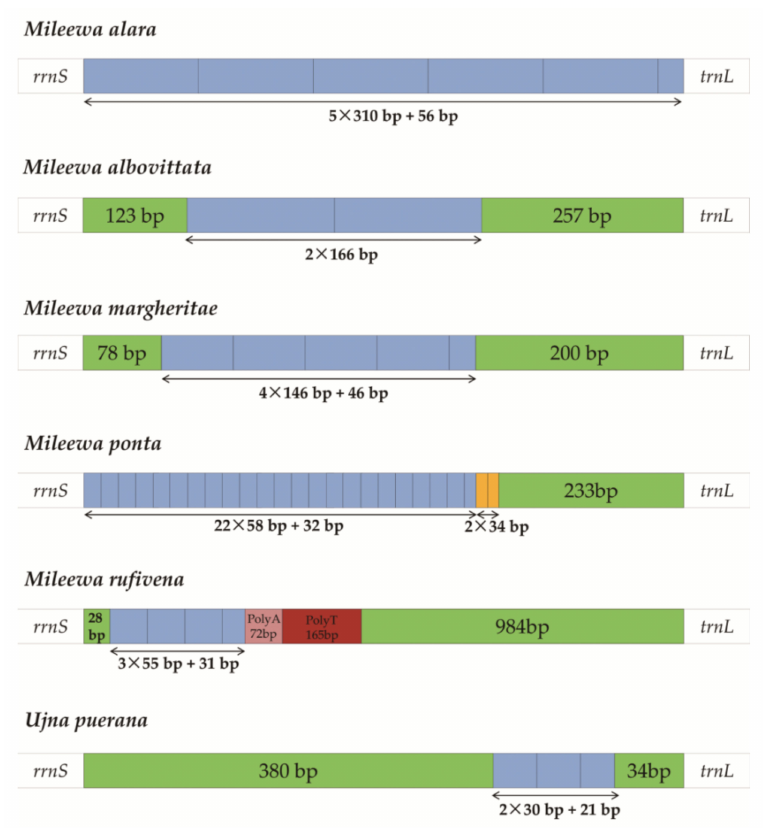
Figure 6. Structures of the A + T-control region in Mileewinae mitochondrial genomes. The blue and orange blocks indicate the tandem repeats, while the pink and red blocks represent the A/T repeat regions. The remaining regions are shown with green